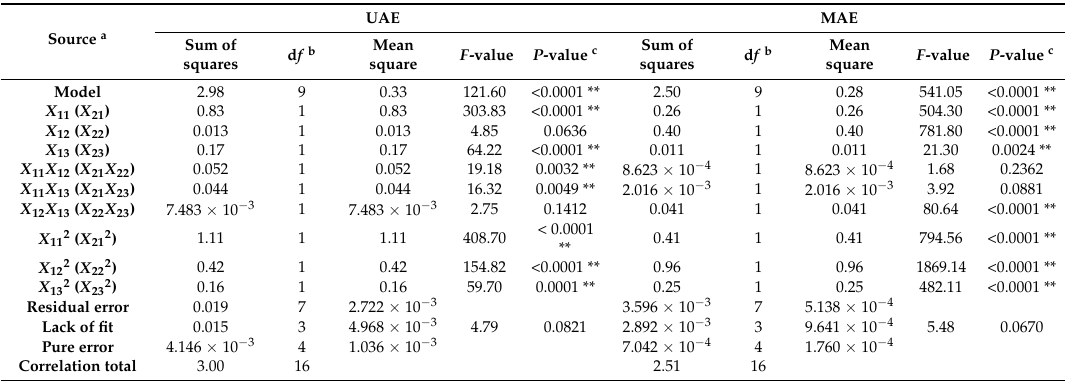
UAE, R 2 = 0.9936, R 2 adj = 0.9855, coefficient of variation = 1.45%, and adeq. precision = 32.118; MAE, R 2 = 0.9986, R 2 adj = 0.9967, coefficient of variation = 0.60%, and adeq. precision = 69.468. a X 11 , ultrasound amplitude (%); X 12 , extraction time (min); X 13 , ratio of water to raw material (mL/g); X 21 , microwave power (W); X 22 , extraction time (min); and X 23 , ratio of water to raw material (mL/g). b df , the degree of freedom. c * significantly